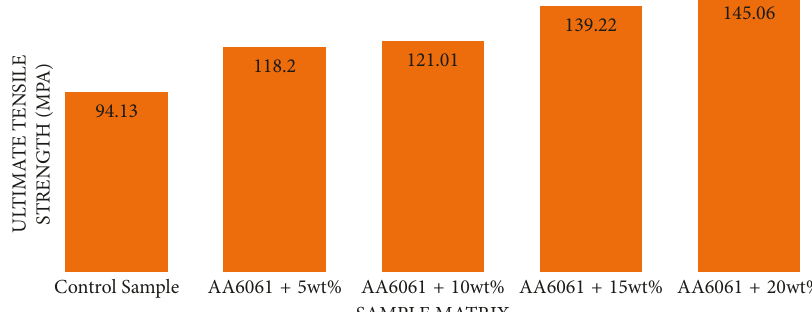
Figure 9: Tensile strength of the reinforced AA6061 alloy matrix composites.